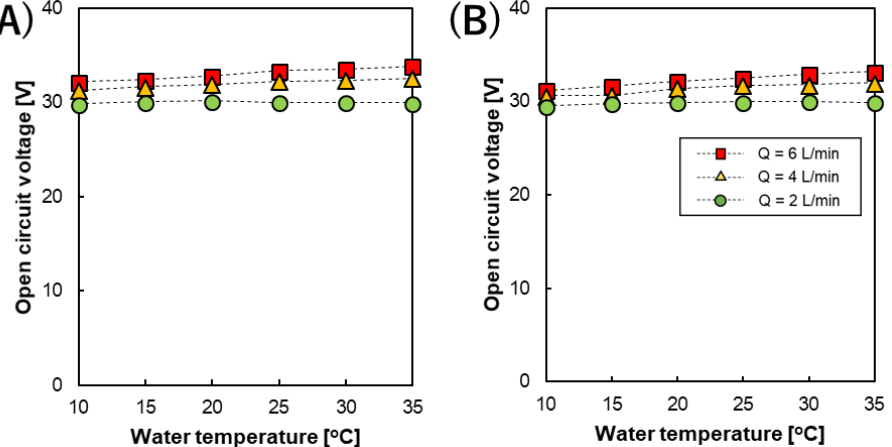
Figure 4. The temperature dependence of the RED stack OCV at di ff erent feed solution flow rates using Figure 4 . The temperature dependence of the RED stack OCV at different feed solution flow rates an intermediate distance in the stack of ( A ) 200 and ( B ) 600 µ m, using an intermediate distance in the stack of ( A ) 200 and ( B ) 600 µm, respectively.